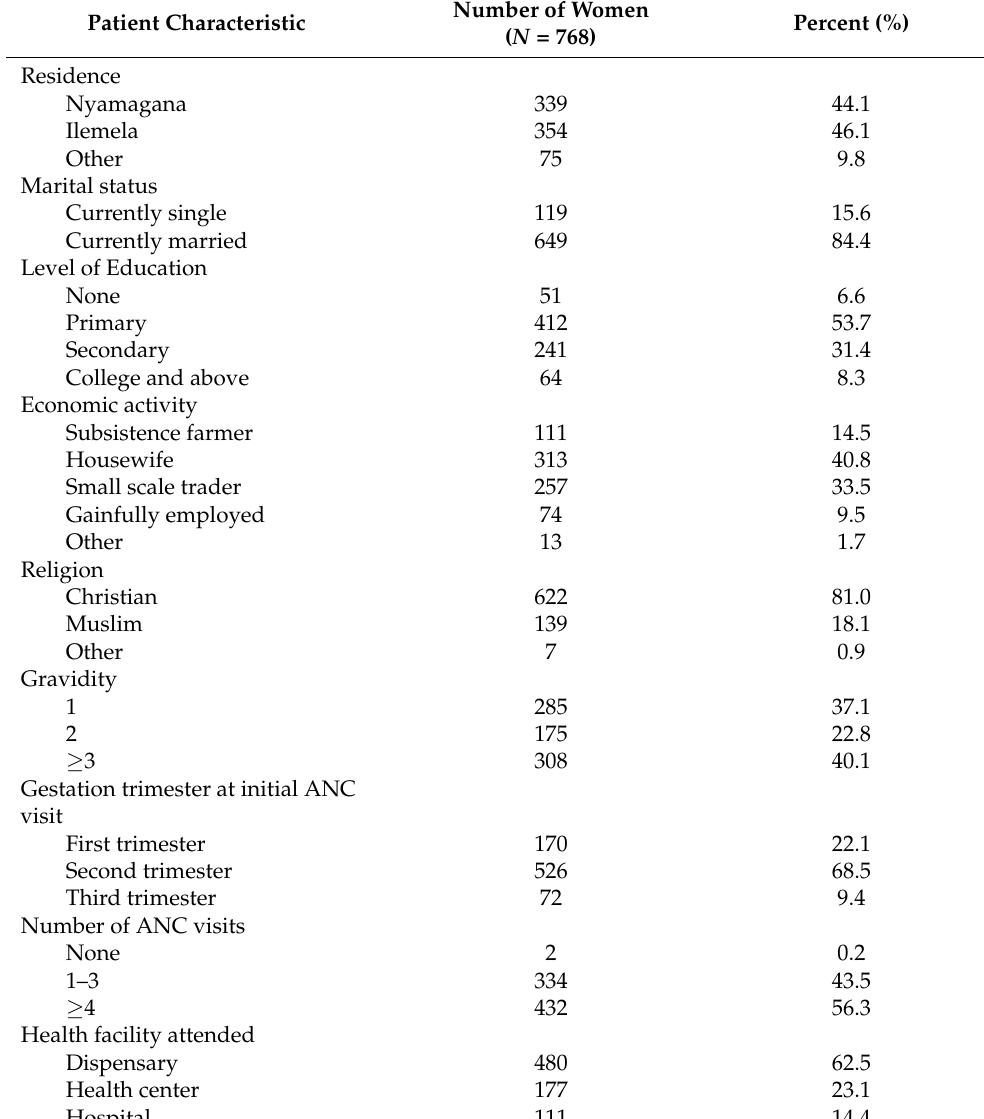
Table 1. Socio-demographic and obstetric characteristics of pregnant women at term from Mwanza city,